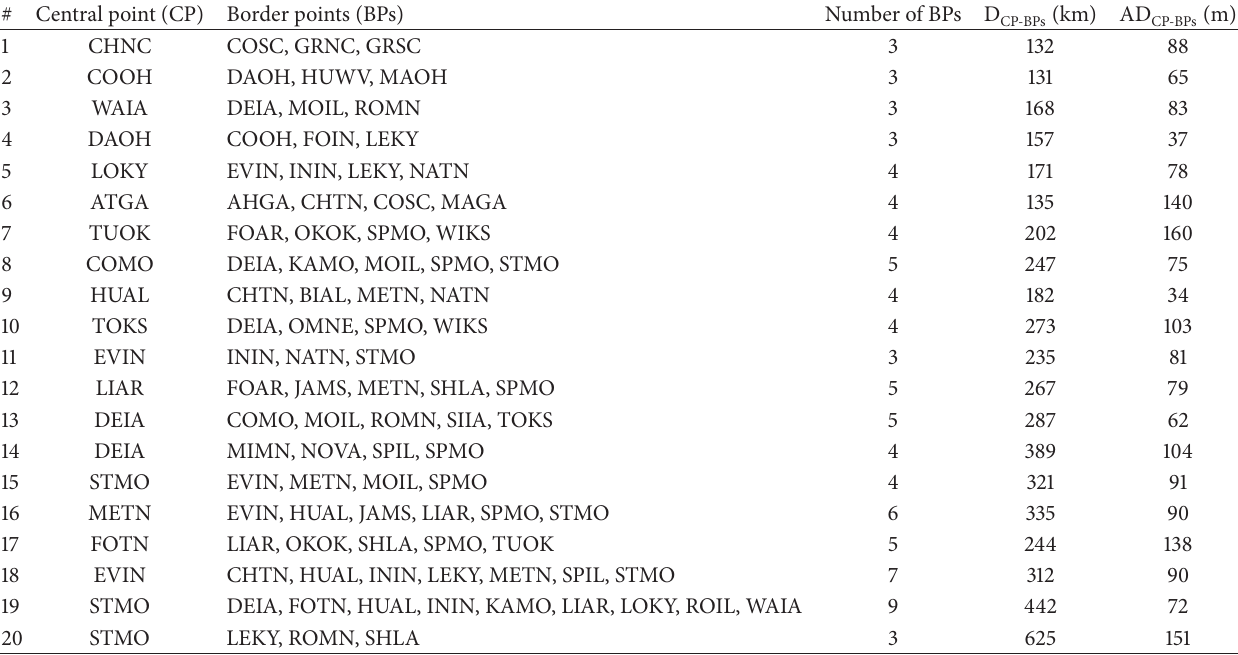
Table 1: Central points (CP) and border points (BP) of the polygons, defined for interpolation of the WG parameters, as well as the average ) and the mean altitude difference (AD ) between the central point and the border points. distance (D CP-BPs CP-BPs # Central point (CP) Border points